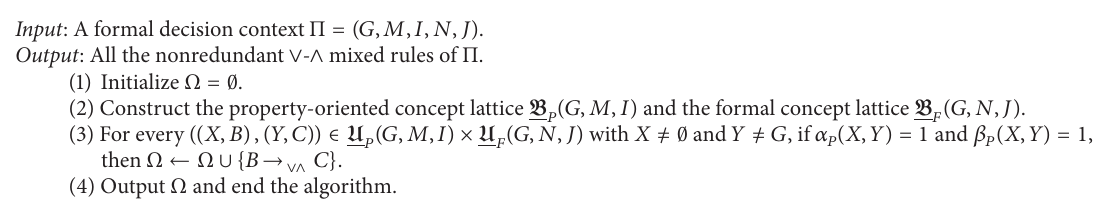
Algorithm 2: Deriving the nonredundant ∨ - ∧ mixed rules from a formal decision context.